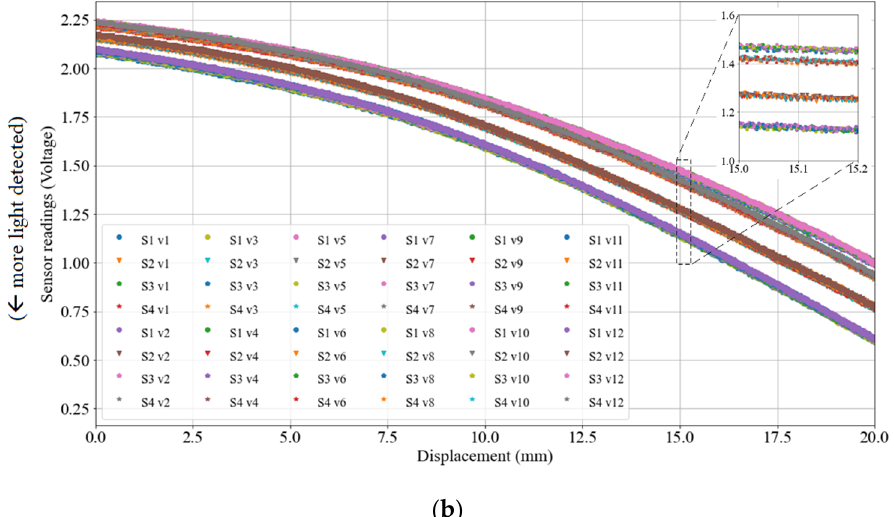
Figure 7. Data collected from the sensors. (a) Relations between pressure sensor signals (in V) and the force (in N). (b) Relations among displacement, sensor signals (S1 to S4, in V), and the speed (v1 to v12, in mm/s).